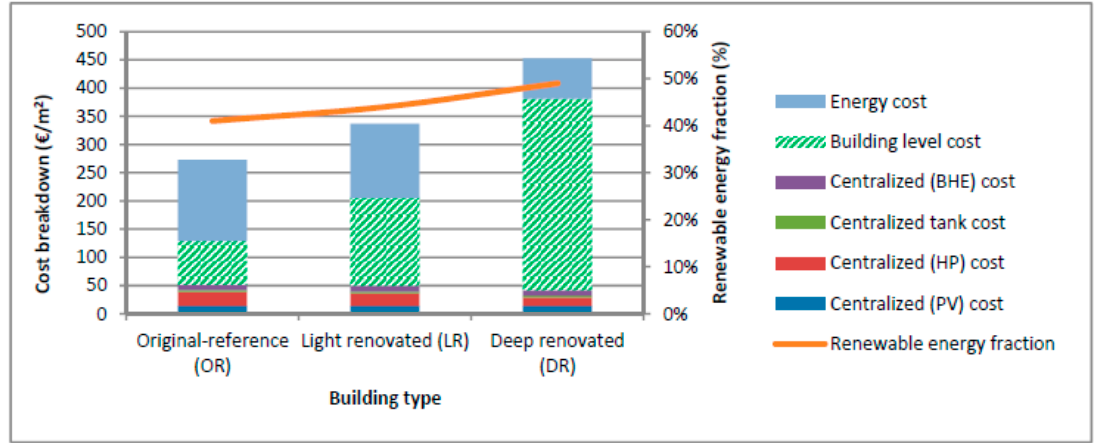
Figure 10. The breakdown of LCC of the old residential building community and centralized energy system based on PV and GSHP (Case 1, PV + GSHP).